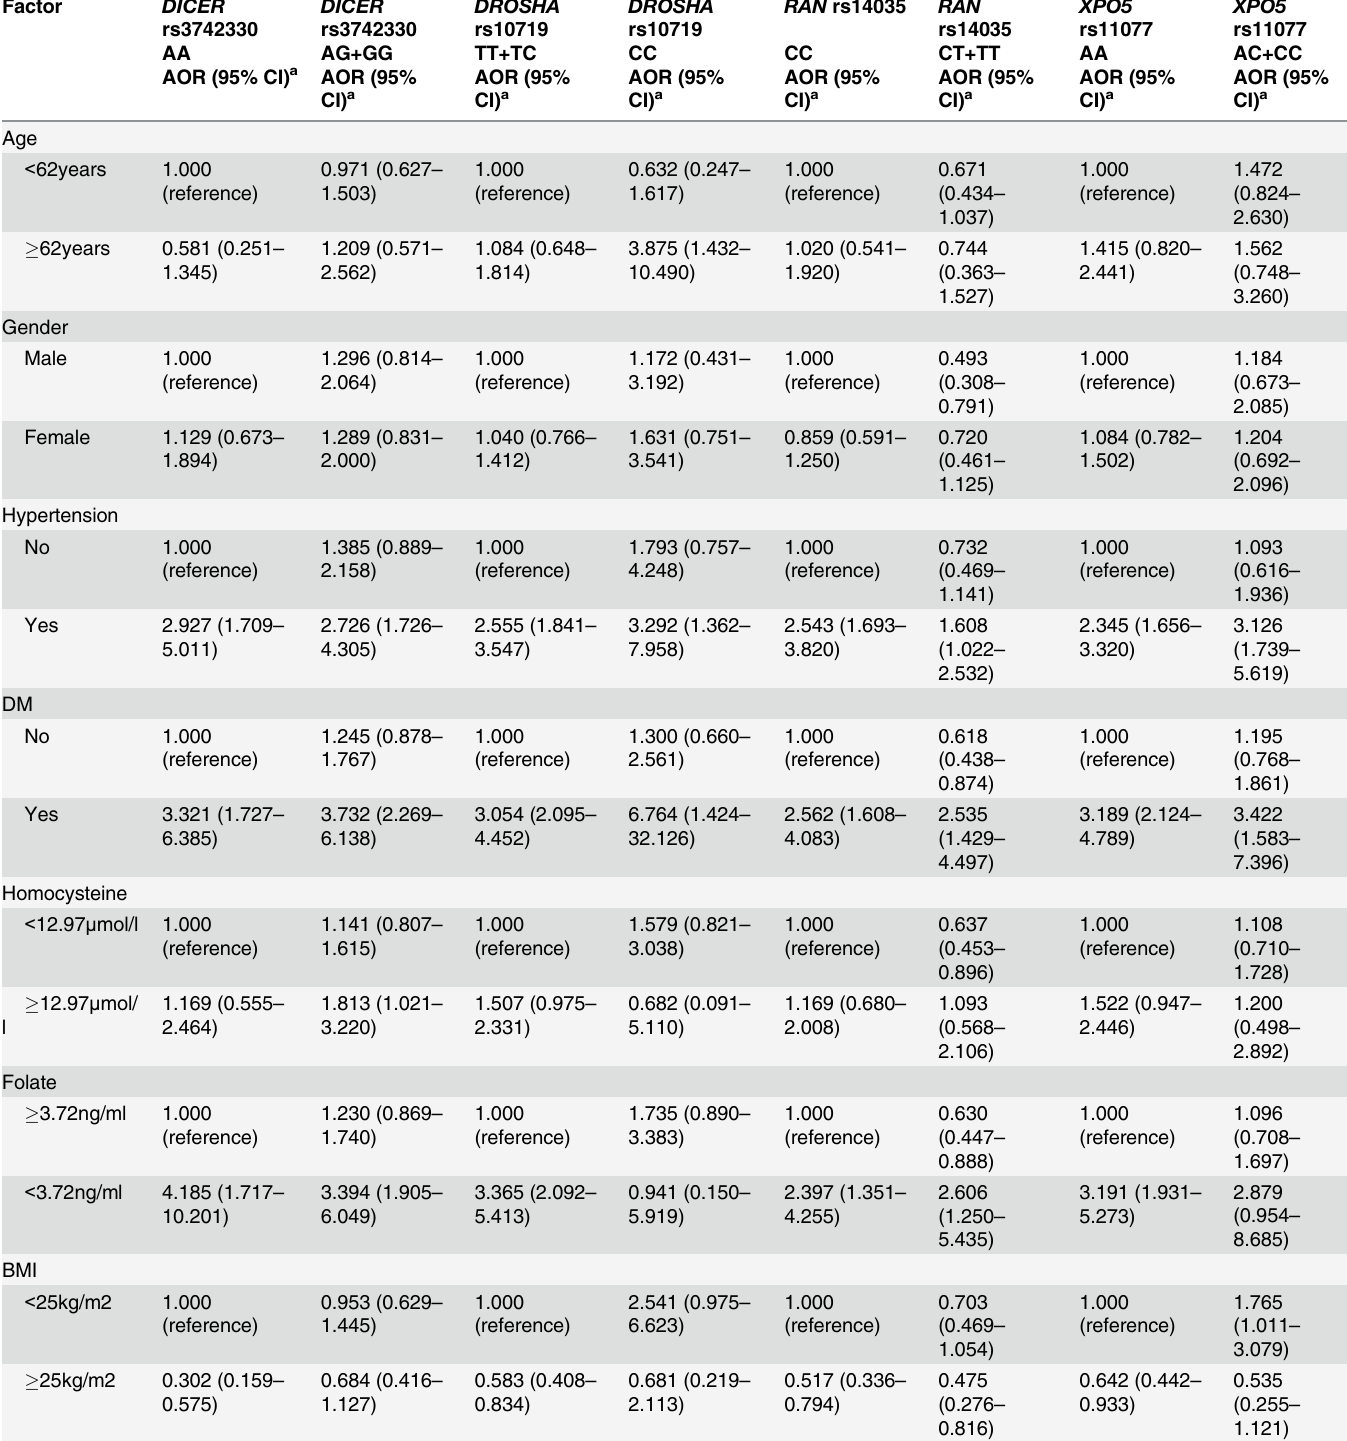
Table 8. Interplay between genes and patients characteristics in shaping colorectal cancer